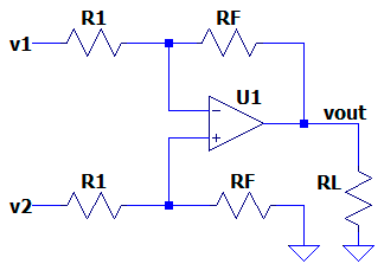
Figure 7. Subtracting amplifier [44].